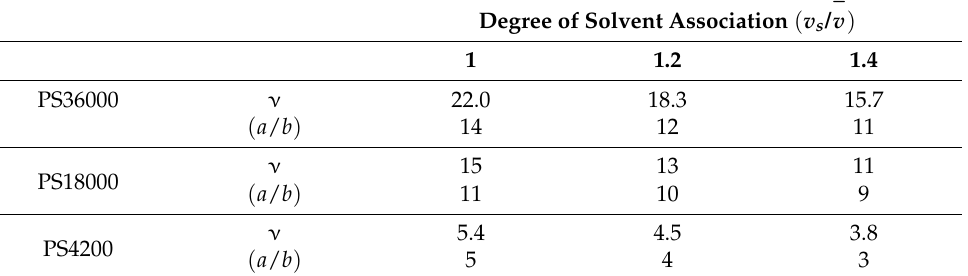
Table 4. Viscosity increment ν for PDMS-OH polymers in turpentine.